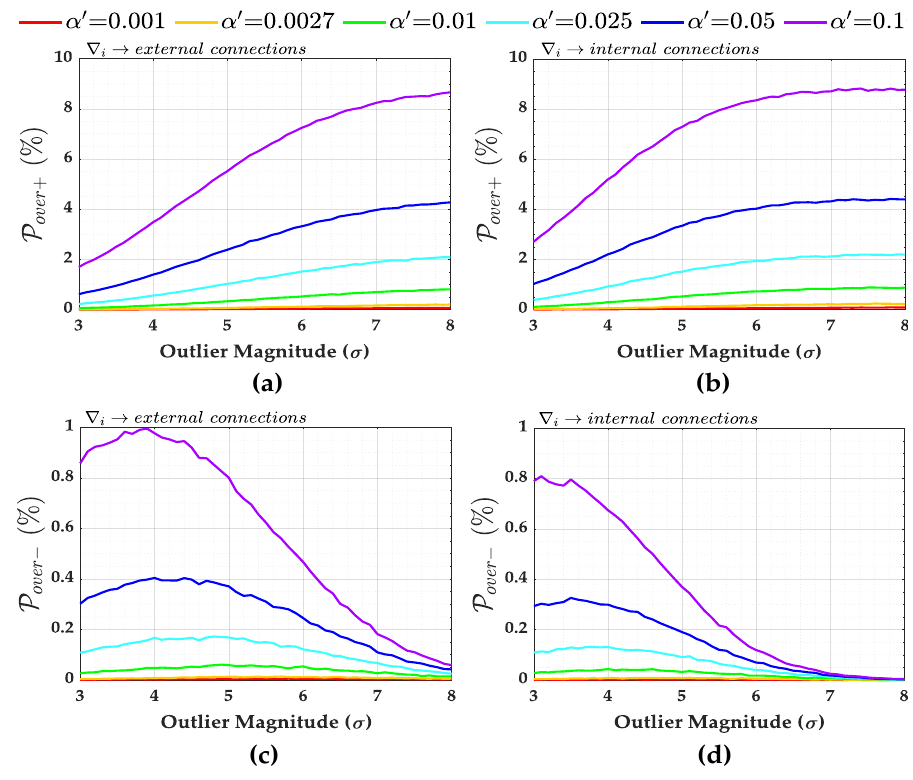
Figure 14. Over-identification cases for network ( a ). ( a ) P over + for external connections. ( b ) P over + for internal connections. ( c ) P over − for external connections. ( d ) P over − for internal connections.